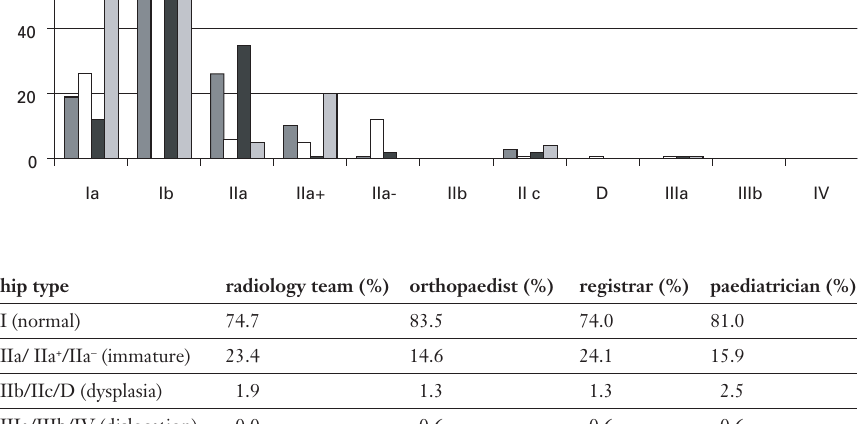
Observer ratings of the Graf classification of 158 sonograms; distribution of types of the Graf classifica- tion by the four groups of observers in absolute numbers.